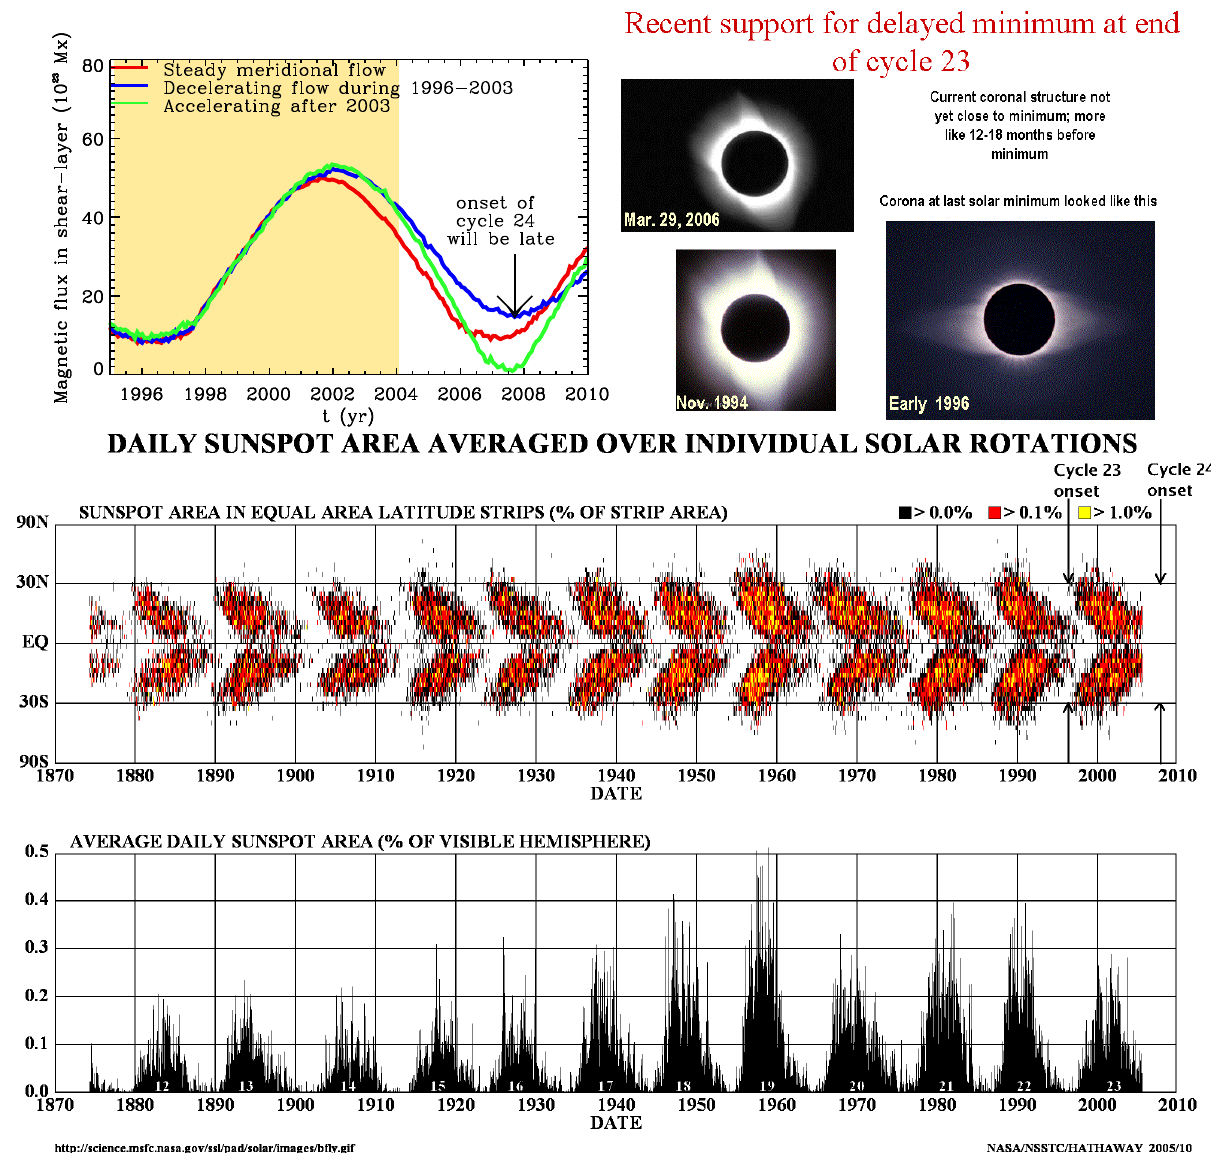
Fig. 3. (a) Time trace of integrated toroidal flux in bottom shear layer for simulations beginning in 1995 with 3 different meridional flow variations with time; (b) Coronal images at eclipse, showing 2006 corona not at minimum phase (c) observed butterfly diagram from David Hathaway’s